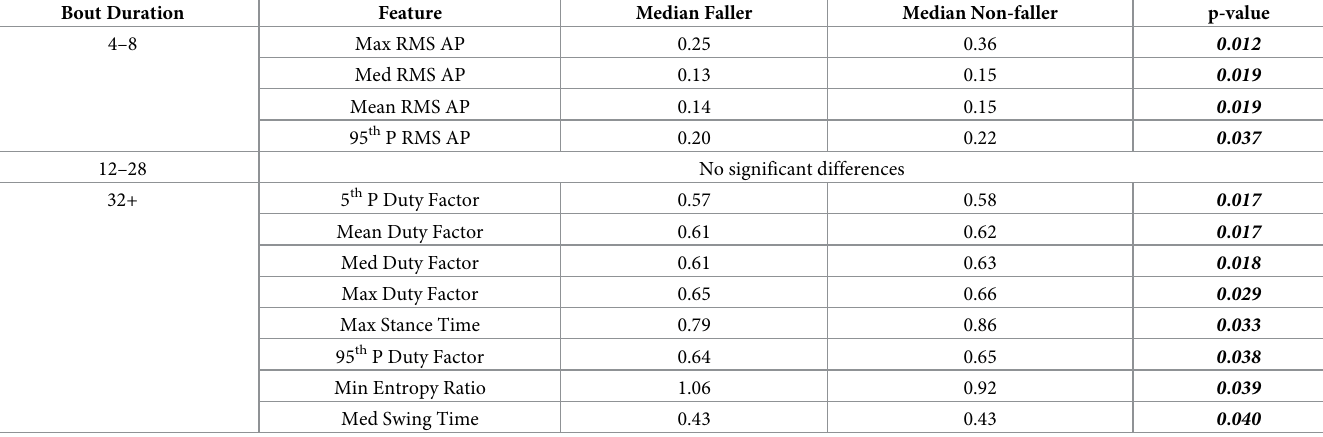
Table 5. Significant Differences of medians of gait parameters for fallers vs non-fallers from differing bout lengths. Bout